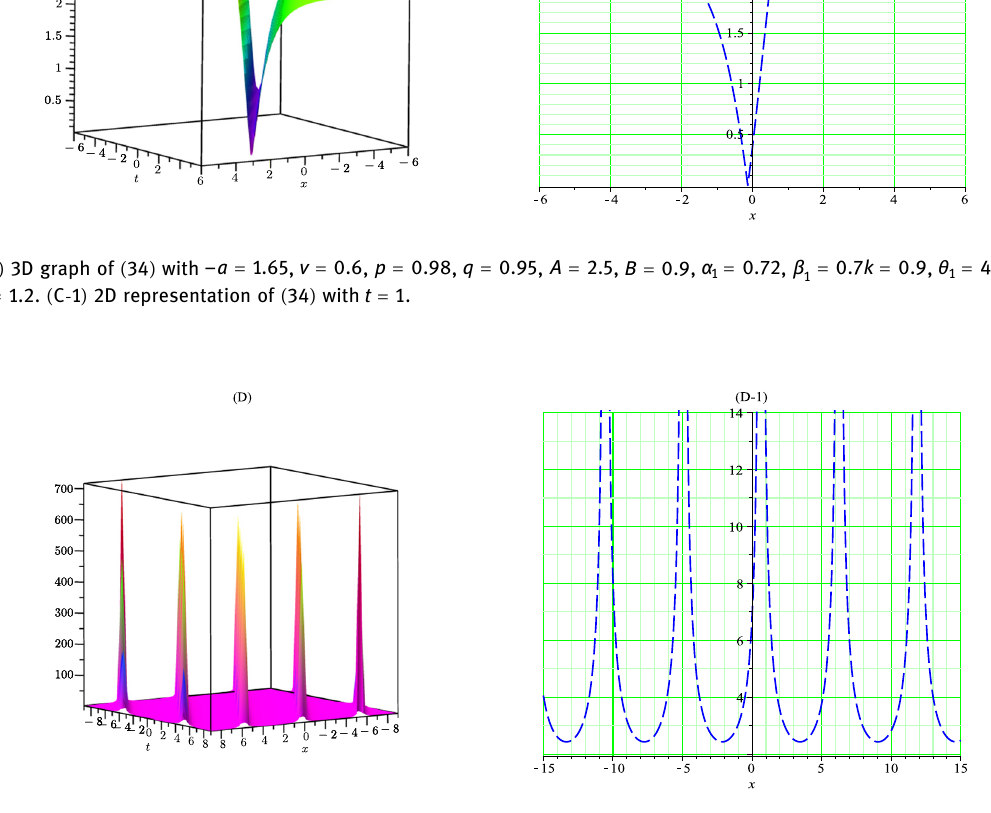
Figure 4: ( D ) 3D graph of ( 41 ) with a 1.55 = . ( D - 1 ) 2D representation of ( 41 ) with t 1 = .